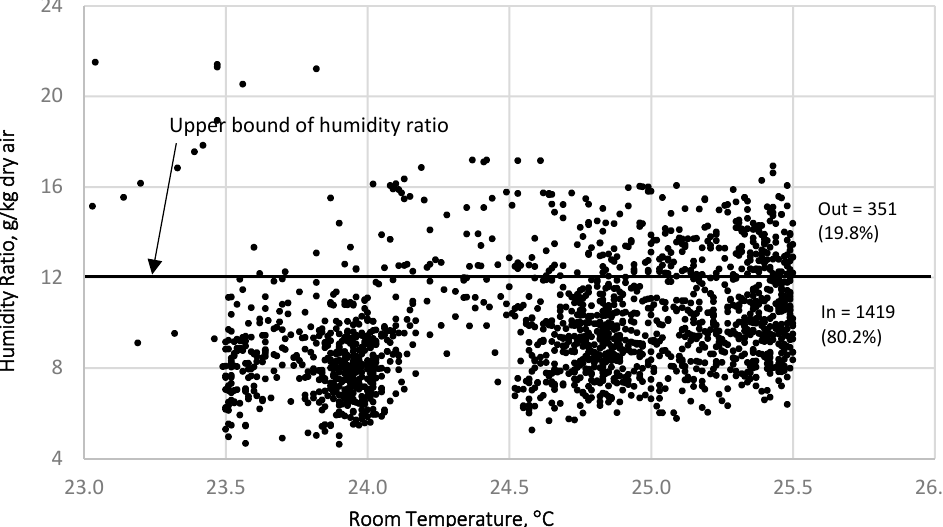
Figure 7. Plots of room temperature vs. humidity for Brisbane (system configuration with SHRW, regeneration temperature 90 °C).